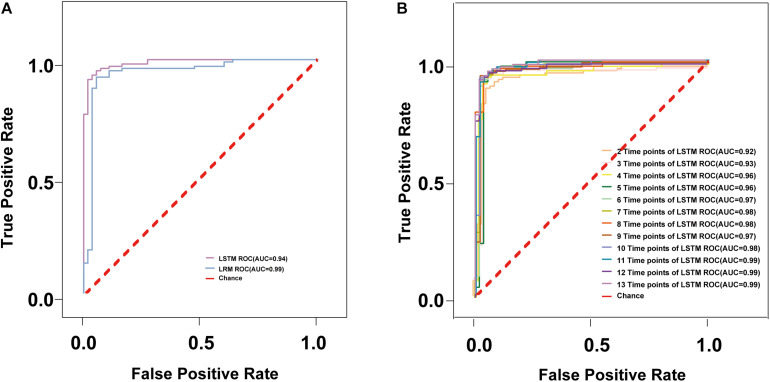
The ROC curves of different models. (A) The ROC curves are shown for the models trained with the multispecies data sets of Linear Regression model and LSTM model; (B) The ROC curves of different time points of LSTM.